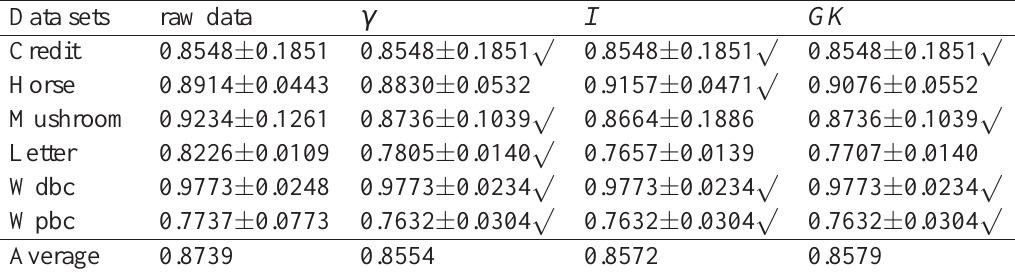
Table 9: Comparison of classification accuracies based on different methods with SVM Data sets